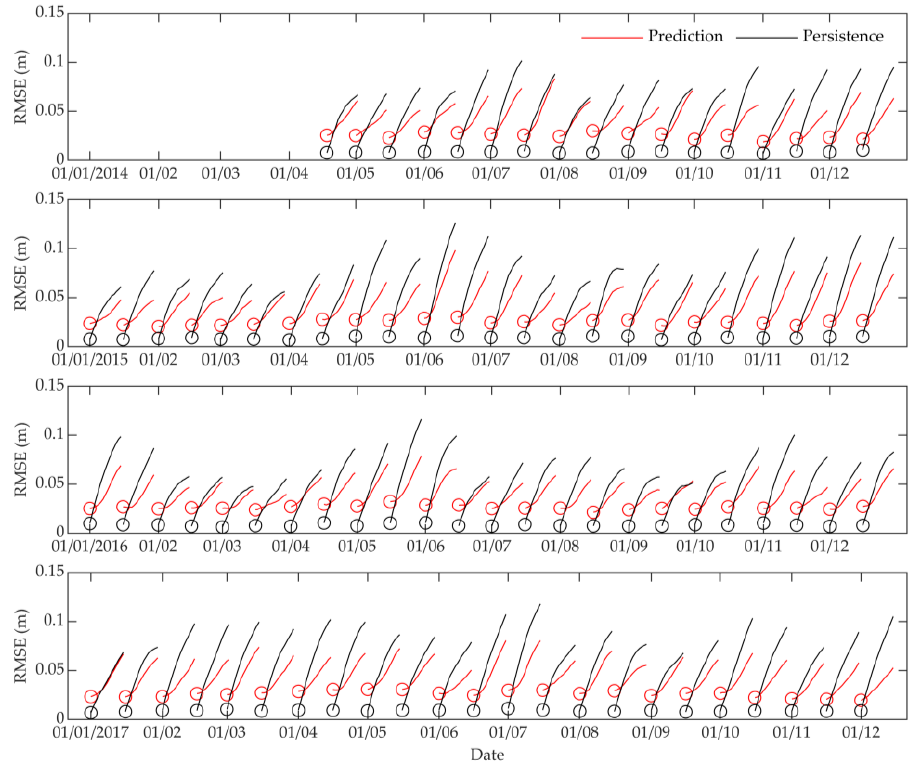
Figure 7. RMSE Comparison of SLA between prediction (red) and persistence (black) from 18 April 2014 to 31 December 2017. The circle represents the position of day 1. The prediction time is 15 days. Circles are plotted every 15 days.